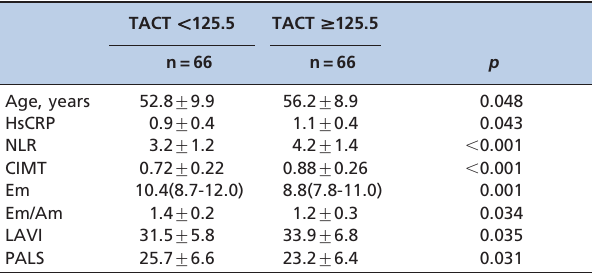
Table 5 - Independent predictors of the total atrial conduction time in the multiple logistic regression analysis.